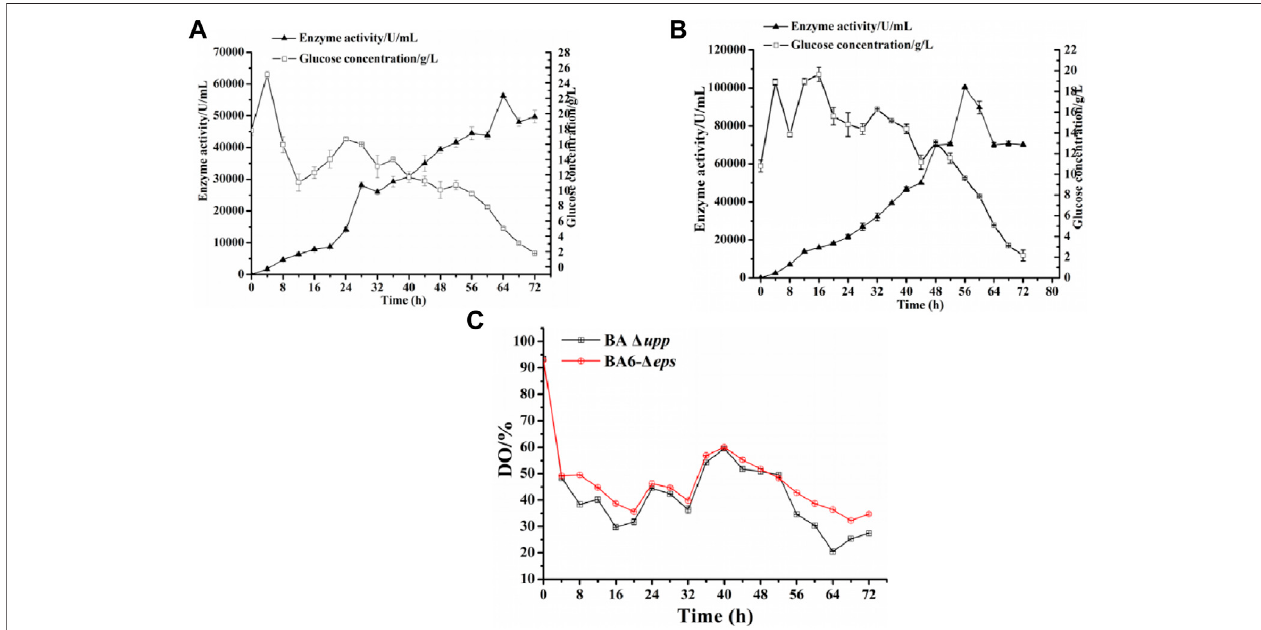
FIGURE 7 | Scaled-up production of alkaline protease by the parental strain BA Δ upp and the best strain BA6- Δ eps in a 5-L fermenter. (A) The alkaline protease enzymeactivityandglucoseconcentrationforBA Δ uppwasmeasuredbyculturingina5-Lfermenterat0 – 72 h.DataarepresentedasmeanvaluesSD.n=3biologically independent samples. (B) The alkaline protease enzyme activity and glucose concentration for BA6- Δ eps was measured by culturing in a 5-L fermenter at 0 – 72 h. Data are presented as mean values SD. n = 3 biologically independent samples. (C) The dissolved oxygen (DO) content of the parent strain BA Δ upp and mutant strain BA6- Δ eps were measured by culturing in a 5-L fermenter at 0 – 72 h. Data are presented as mean values SD. n = 3 biologically independent